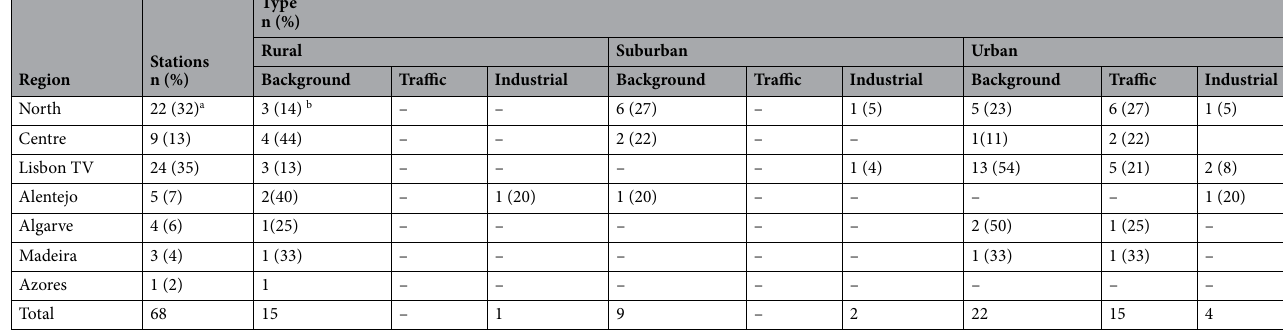
Table 1. Air pollution monitoring network in Portugal: summary of zone- and emission influence-specific monitoring sites in each region. a % considering the whole territory. b Indicated % is estimated considering of abundance of a station/type in each district. Depending on the density and distribution of buildings, stations are classified as the folloing: rural—all other areas; suburban—largely built-up; urban area urban— continuously built-up urban area; background stations—pollution levels are representative of the average exposure of the general population or vegetation; traffic—situated in a close proximity to a single major road; industrial stations—situated in close proximity to an industrial area or an industrial source 27